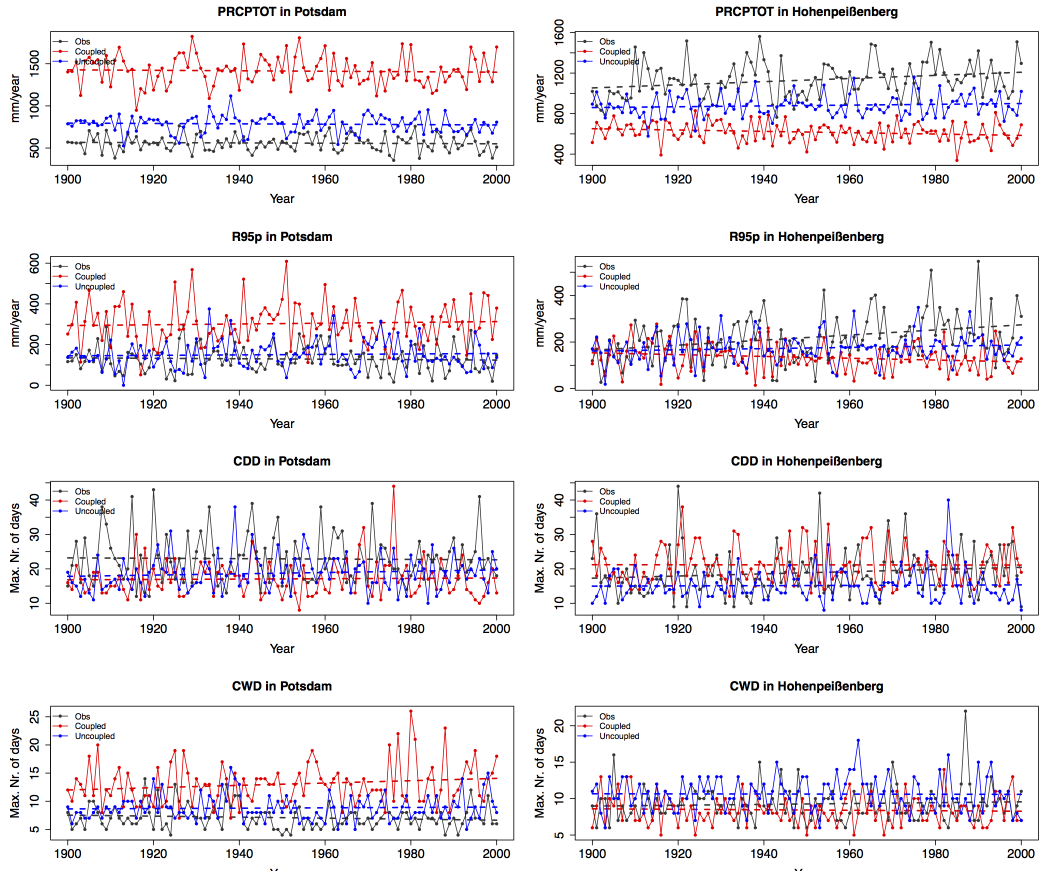
Figure 16. Temporal evolution of four climate change indices related to precipitation at two German stations: Potsdam (81m) and Ho- henpeißenberg (977m). PRCPTOT represents the annual total precipitation on wet days, R95p is the annual total PRCP when the daily precipitation (RR) is above the 95th percentile of precipitation on wet days in the 1961–1990 period, CDD is the maximum length of dry spell (maximum number of consecutive days with RR < 1mm), and CWD is the maximum length of wet spell (maximum number of consecutive days with RR ≥ 1mm). Linear trends are shown as dashed